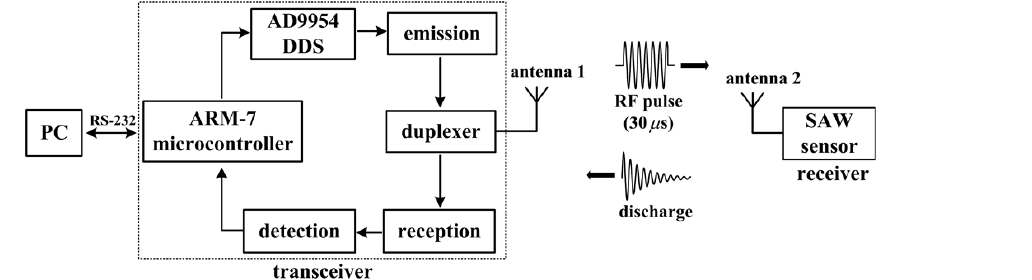
Figure 1. Diagram of the resonator interrogation principle based on the RADAR strategy.